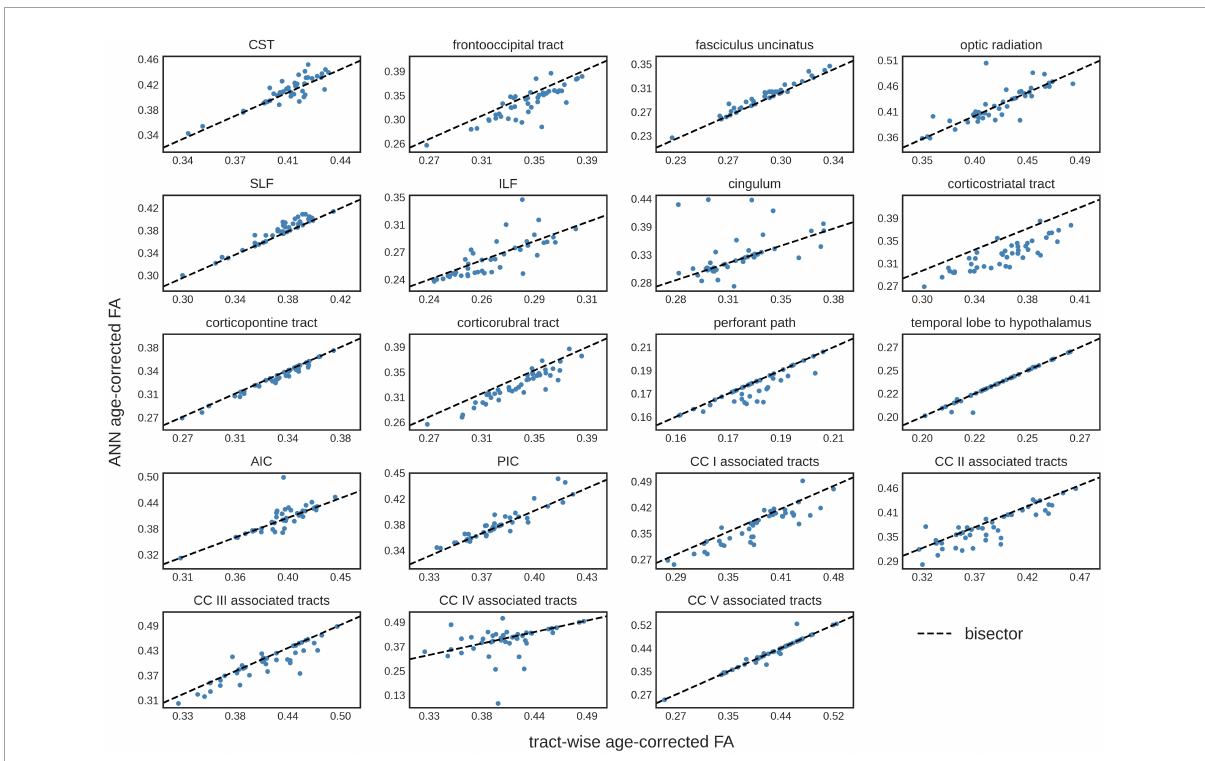
FIGURE3 Tract-wise comparison of two different approaches for age correction of fractional anisotropy (FA) values. The tract-wise linear age-corrected FA values is plotted against the artificial neural network (ANN) age-corrected FA values of each subject in the test data set ( N = 43). The bisector is displayed as a “guide for the eye.” CST, corticospinal tract; SLF, superior longitudinal fasciculus; ILF, inferior longitudinal fasciculus; AIC, anterior limb of internal capsule; PIC, posterior limb of internal capsule; CC, corpus